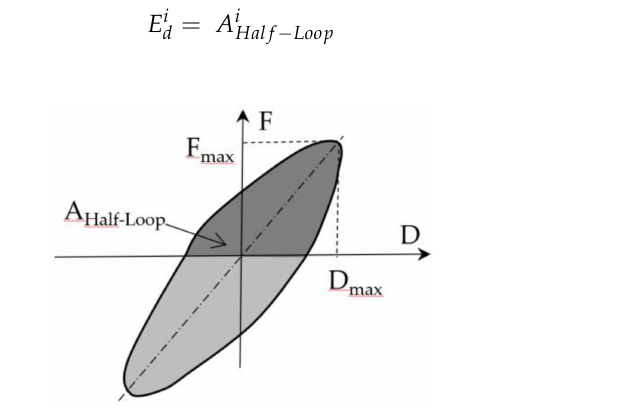
during the Tol part of the d